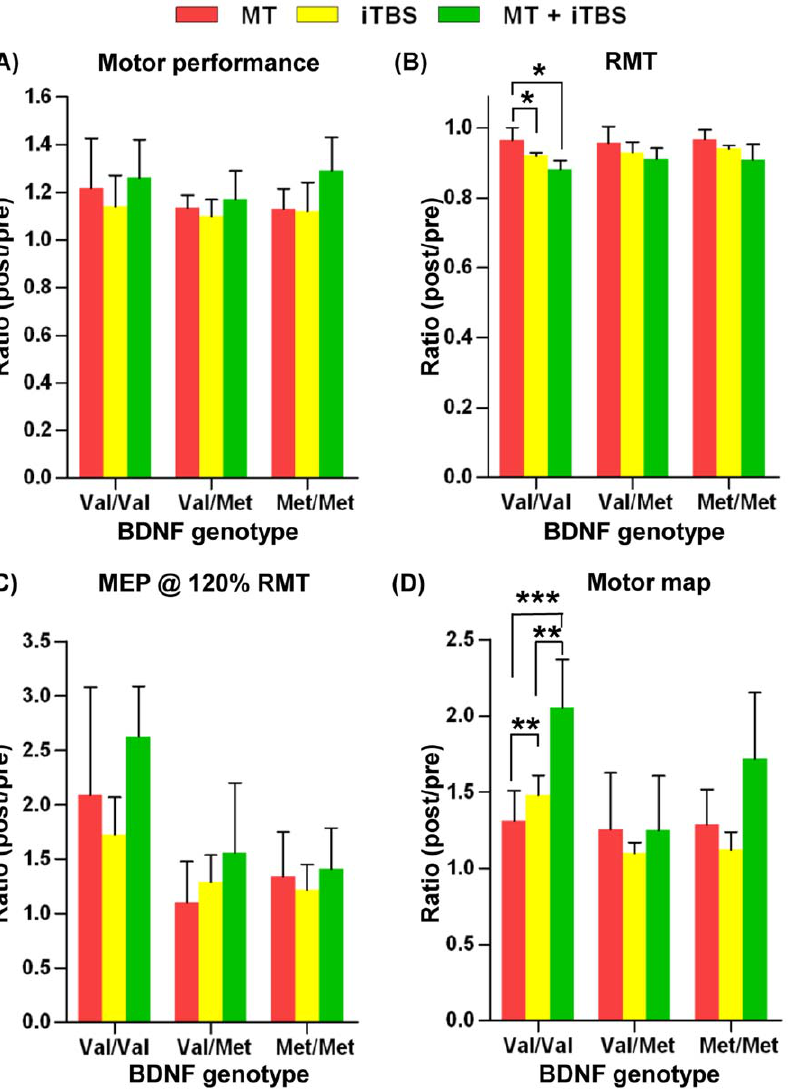
Figure 4. Quantitative comparison of changes in motor cortical physiology by three different paradigms. Red, yellow, and green bars represent ratios of post/pre-motor training (MT), post/pre-intermittent theta burst stimulation (iTBS), and post/pre MT + iTBS values in motor behavior performances and motor cortical physiology variables, respectively. Subjects were grouped by BDNF Val66Met genotypes. ( A ) Motor behavior performances measured by the numbers of finger tapping in one minute. ( B ) Resting motor threshold (RMT) measured as a percentage of magnetic output. ( C ) Motor map areas. *, **, and *** denote p , 0.05, p , 0.01, and p , 0.001 by a general linear model two way ANOVA followed by a posthoc Bonferroni